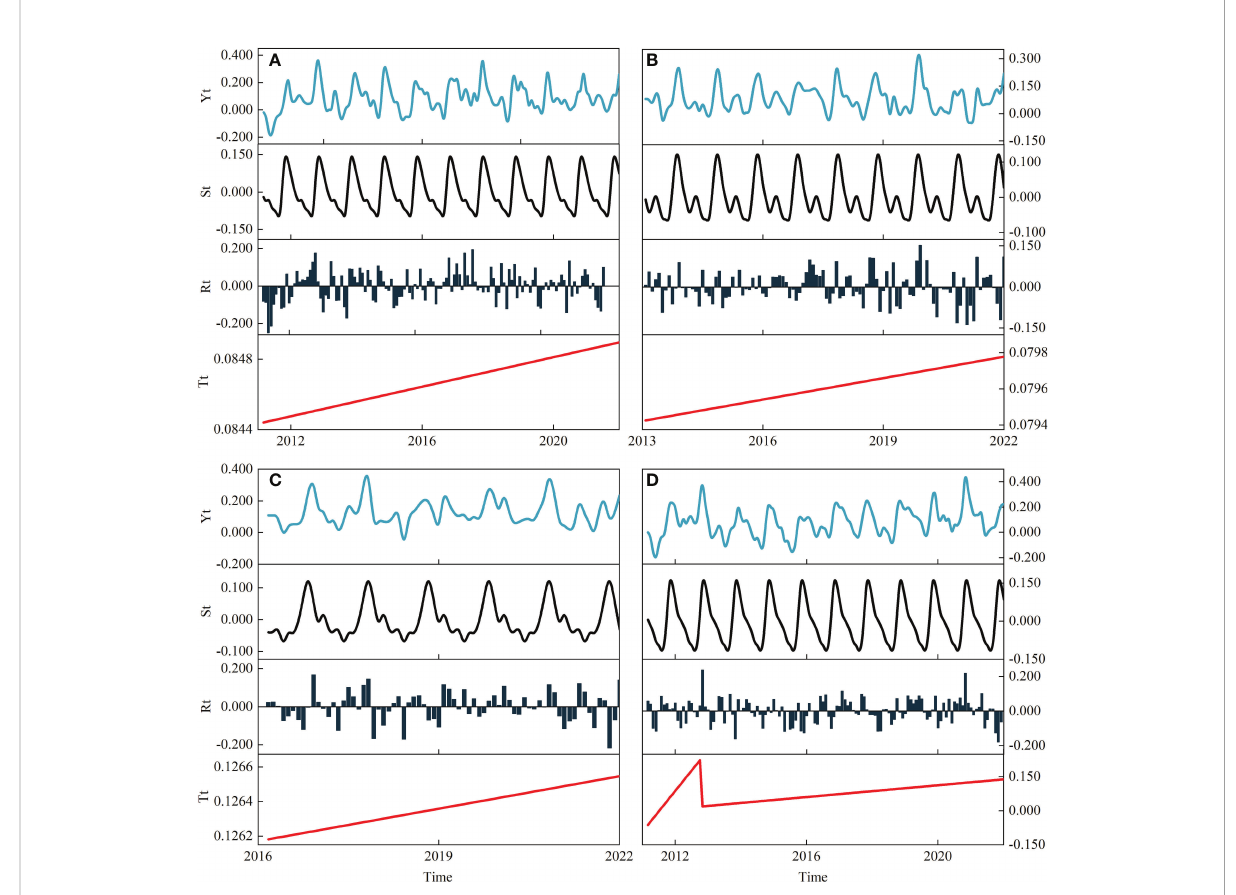
FIGURE 9 Decomposition results of four time-series water levels based on the BFAST algorithm. (A) Cryosat-2, (B) SARAL, (C) Sentinel-3, (D) Multi-